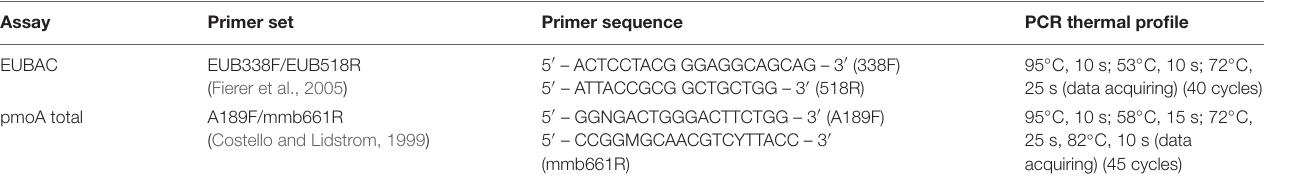
TABLE 3 | Primers and PCR programs for the qPCR assays used in the